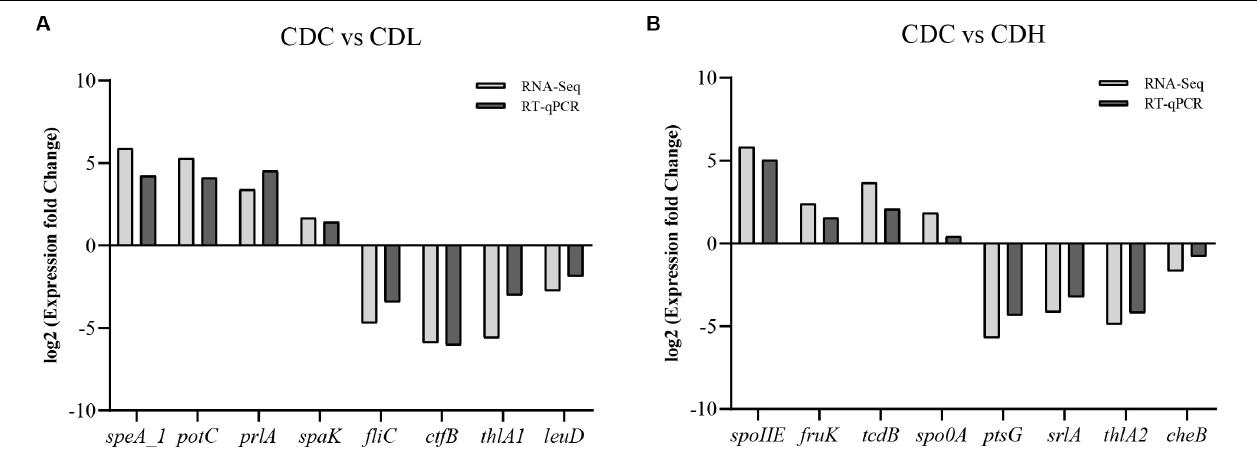
FIGURE 8 | Comparison of RT-qPCR and RNA-Seq data for selected key C. difficile ATCC 9689 genes (the R 2 value was 0.92 in CDL (A) and 0.91 in CDH (B)